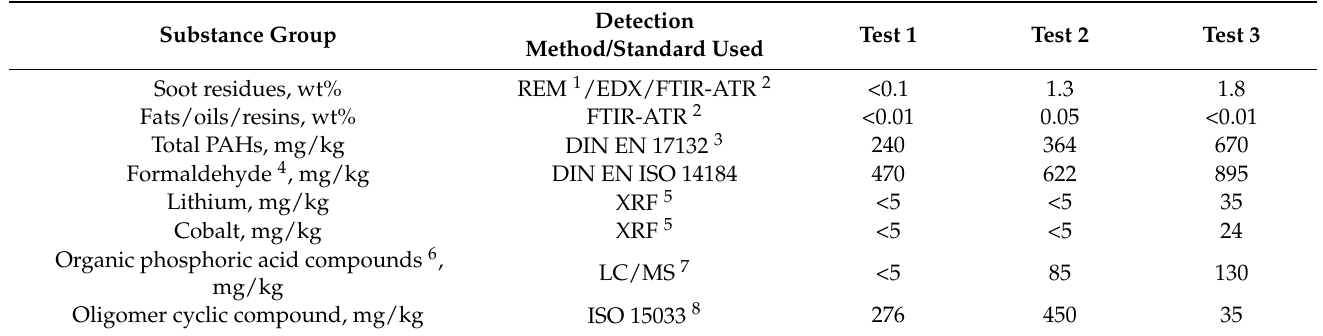
Table 5. Experimental results (total in all the firefighters clothing